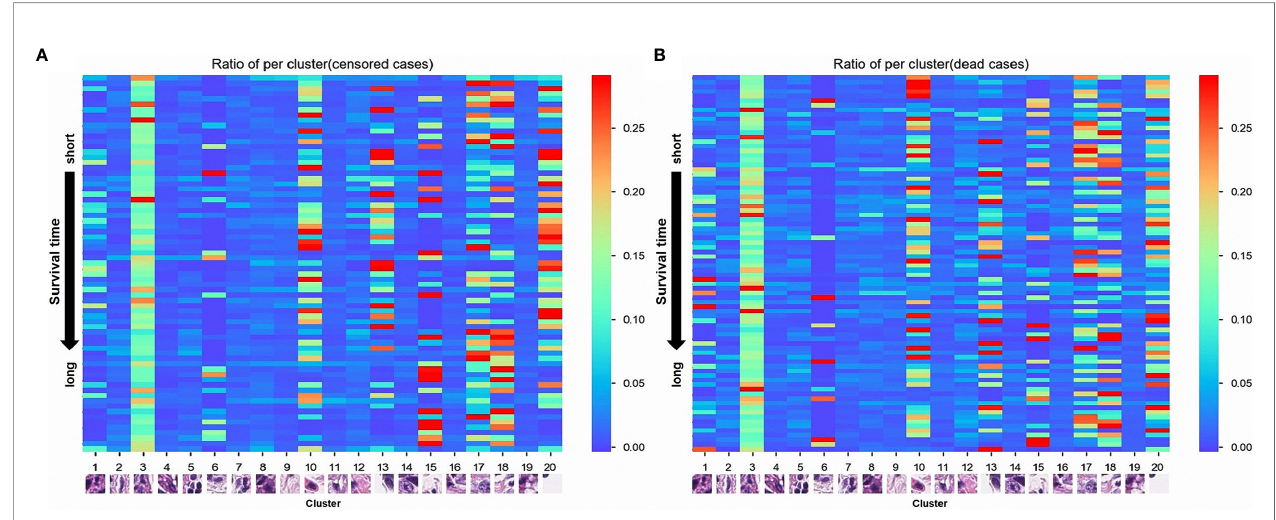
FIGURE 2 | (A) The distribution of 20 pathological patches cluster ratio (PPCR) features in alive patients with esophageal squamous cell cancer (ESCC); (B) The distribution of 20 PPCR features in dead patients with ESCC.